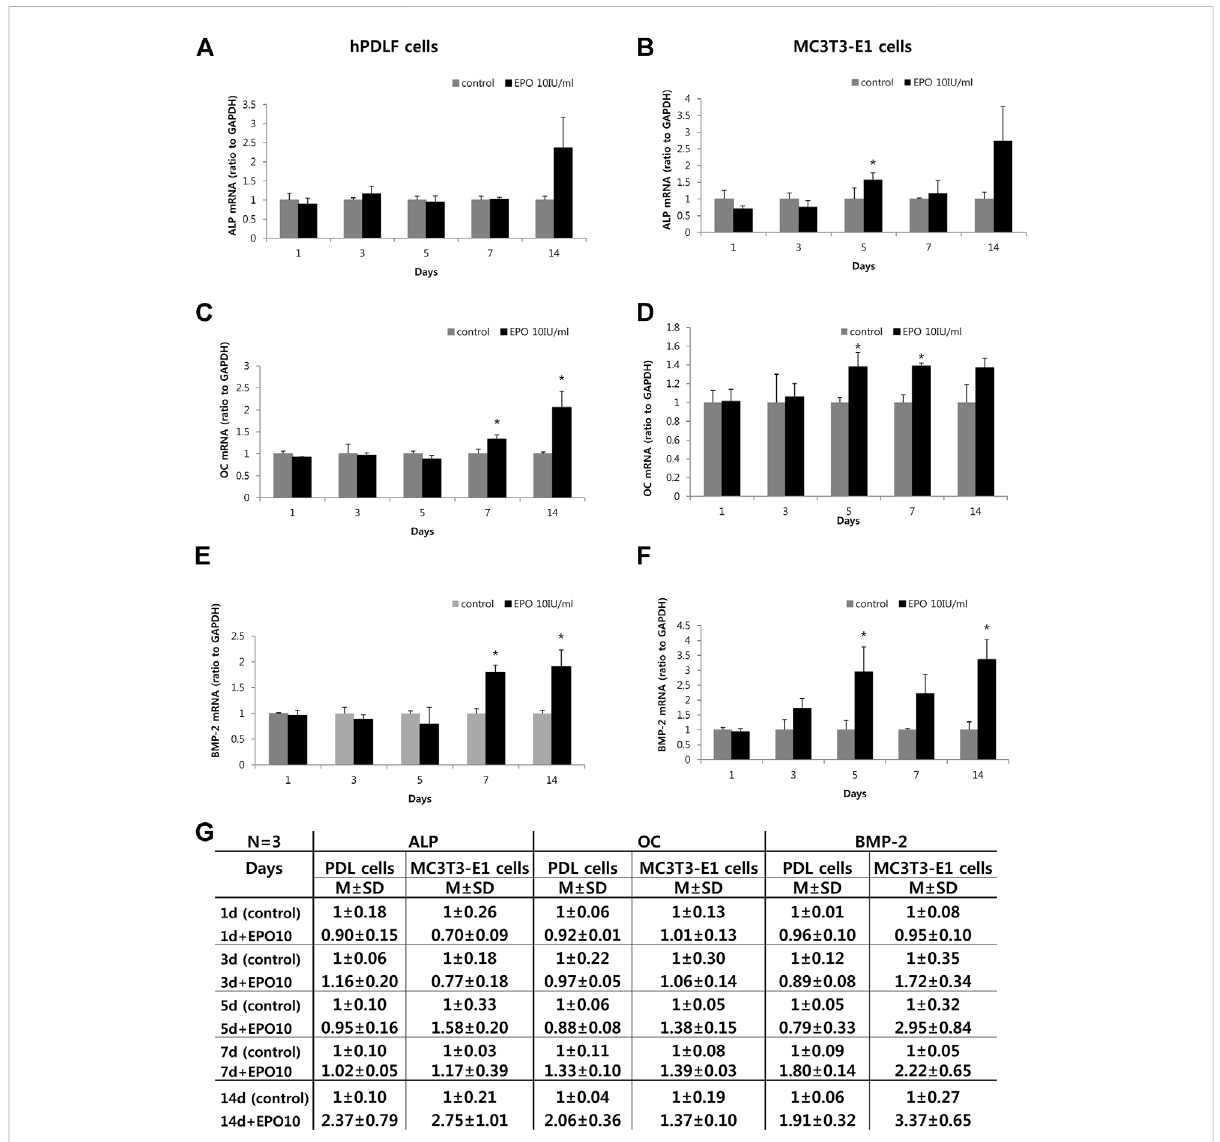
FIGURE 2 Effect of EPO on osteogenic gene markers of hPDLF cells (A,C,E,G) and MC3T3-E1 cells (B,D,F,G) . Treatment with 10 IU/ml EPO show the highestalkalinephosphatase(ALP)expressiononday14,butnosigni fi canteffectisobservedonthehPDLFcells (A) .Incontrast,MC3T3-E1cellsshow signi fi cantly higher ALP expression on day 5 (B) . Signi fi cantly higher expression level of osteocalcin (OC) is observed on day 7 and 14 on the hPDLF cells (C) , but the MC3T3-E1 cells show signi fi cantly higher values on days 5 and 7 (D) . Signi fi cantly higher expression level of bone morphogeneticprotein-2(BMP-2)isobservedonday7and14inhPDLFcells (E) ,butappearmorerapidly,ondays5and14,intheMC3T3-E1cells (F) . The experiments are conducted three times independently. Data are shown as mean (M) ± standard deviation (SD). *Statistically signi fi cant differences compared to the untreated control ( p <